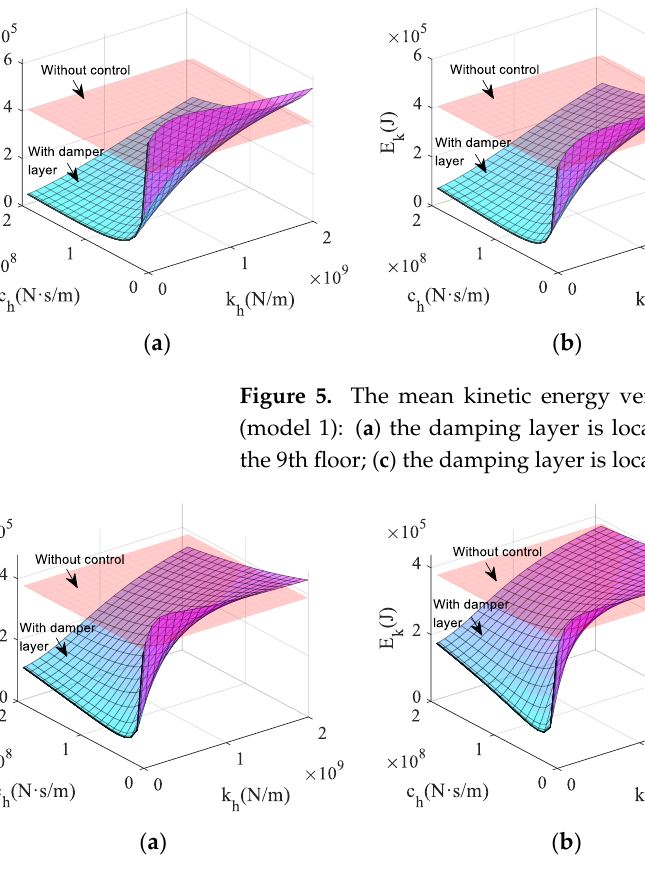
Figure 6. The mean kinetic energy versus the parameters and position of the damping layer (model 2): ( a ) the damping layer is located at the 3rd floor; ( b ) the damping layer is located at the 9th floor; ( c ) the damping layer is located at the 15th floor.